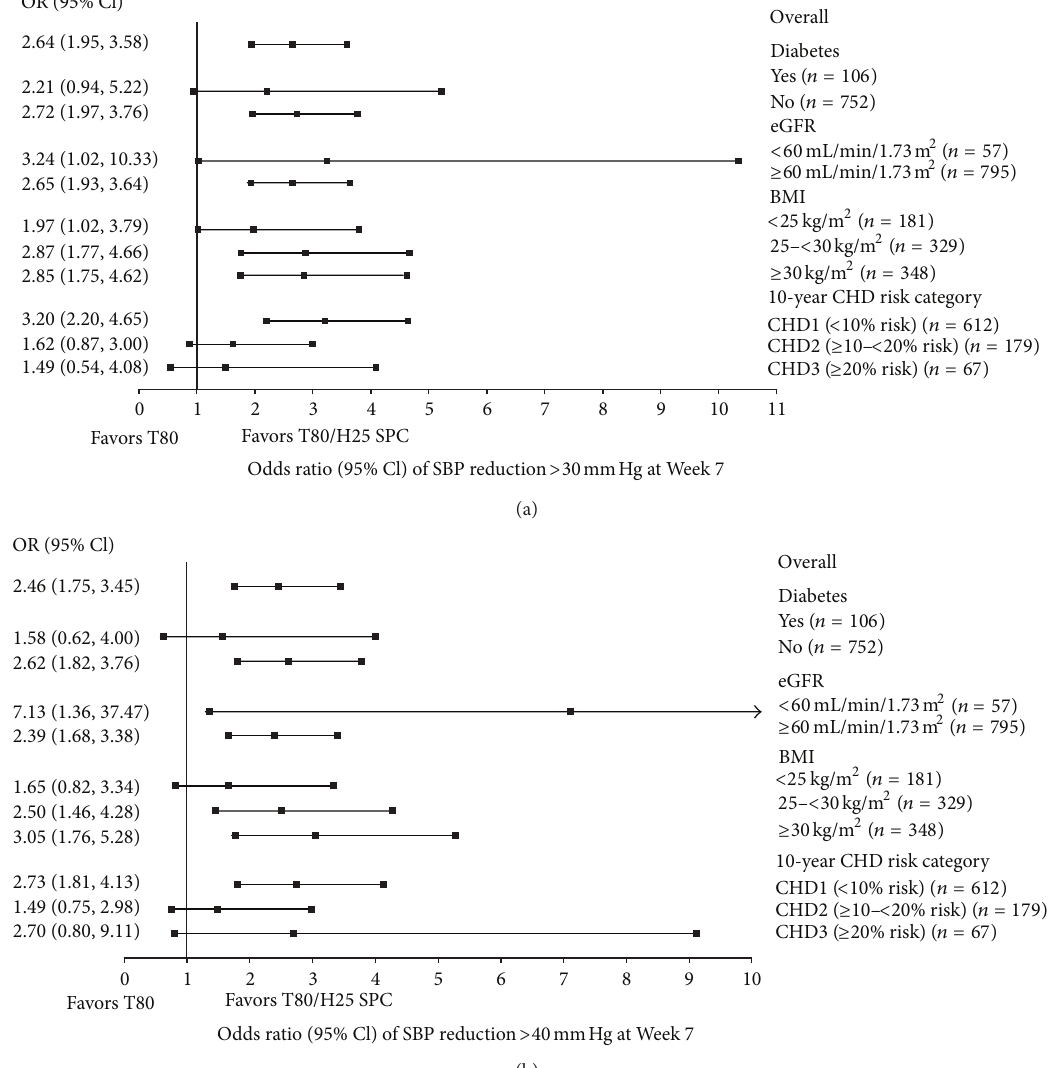
Figure 3: ORs (95% CI) of SPC T80/H25 versus T80 for proportion of patients with seated trough cuff SBP reduction (a) > 30mmHg and (b) > 40mmHg at Week 7 by patient subgroup (FAS). BMI: body mass index; CHD, coronary heart disease; CI: confidence interval; eGFR, estimated glomerular filtration rate; FAS: full analysis set; H25: hydrochlorothiazide 25mg; OR: odds ratio; SBP: systolic blood pressure; SPC, single-pill combination; T80: telmisartan 80 mg.